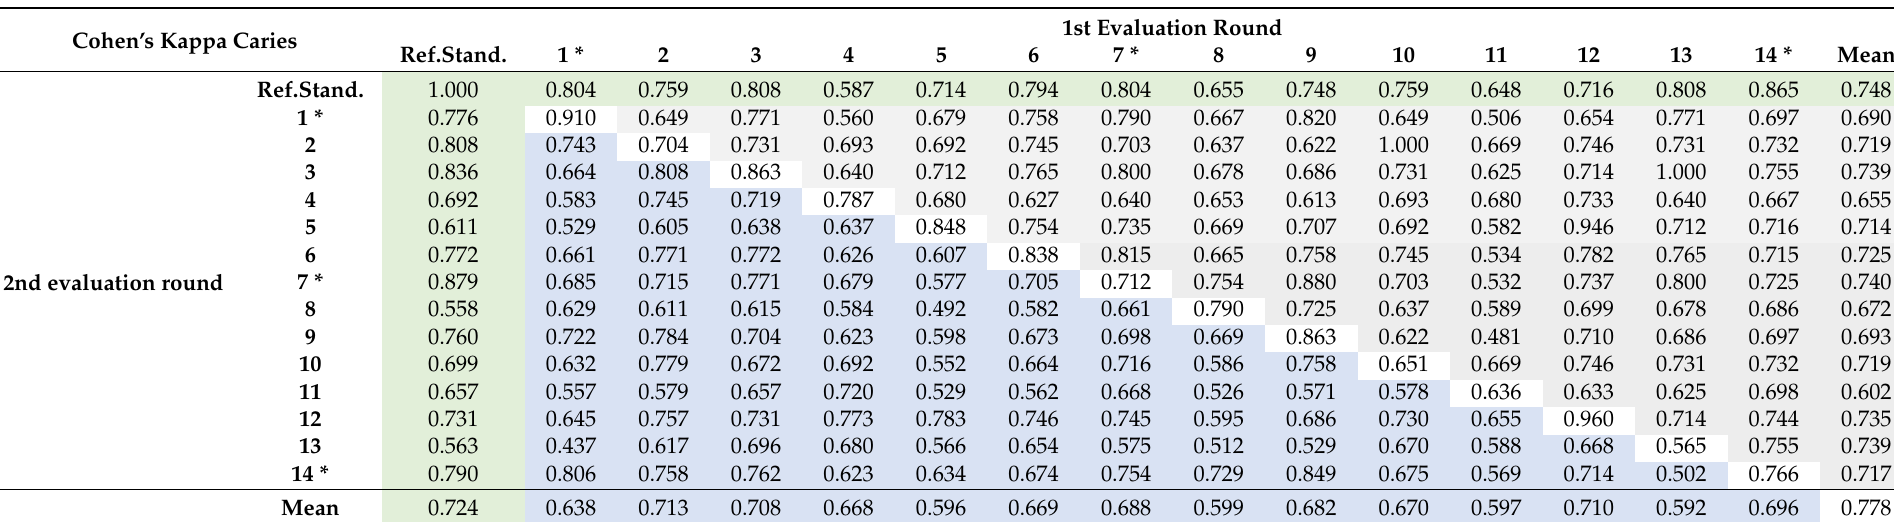
Table 1. Values of inter- and intra-rater reliability for caries detection which was calculated among all dentists (N = 14) and in relation to the reference standard (green coloured boxes). Grey coloured boxes illustrate inter-rater CK values of the first assessment and blue coloured boxes for the second assessment. White fields indicate intra-rater CK